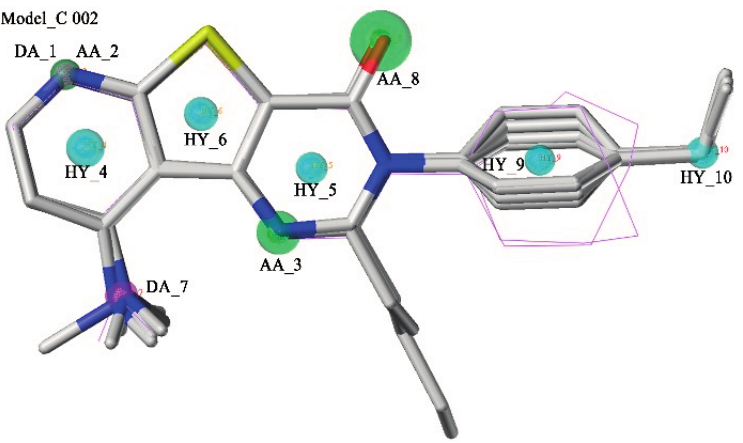
Figure 2. Pharmacophore models and molecular alignment of the compounds used to elaborate the model. In order, they are Model_A018, Model_B014, and Model_C002, respectively. Cyan indicates hydrophobic features, green indicates hydrogen bond acceptors, and purple indicates hydrogen bond